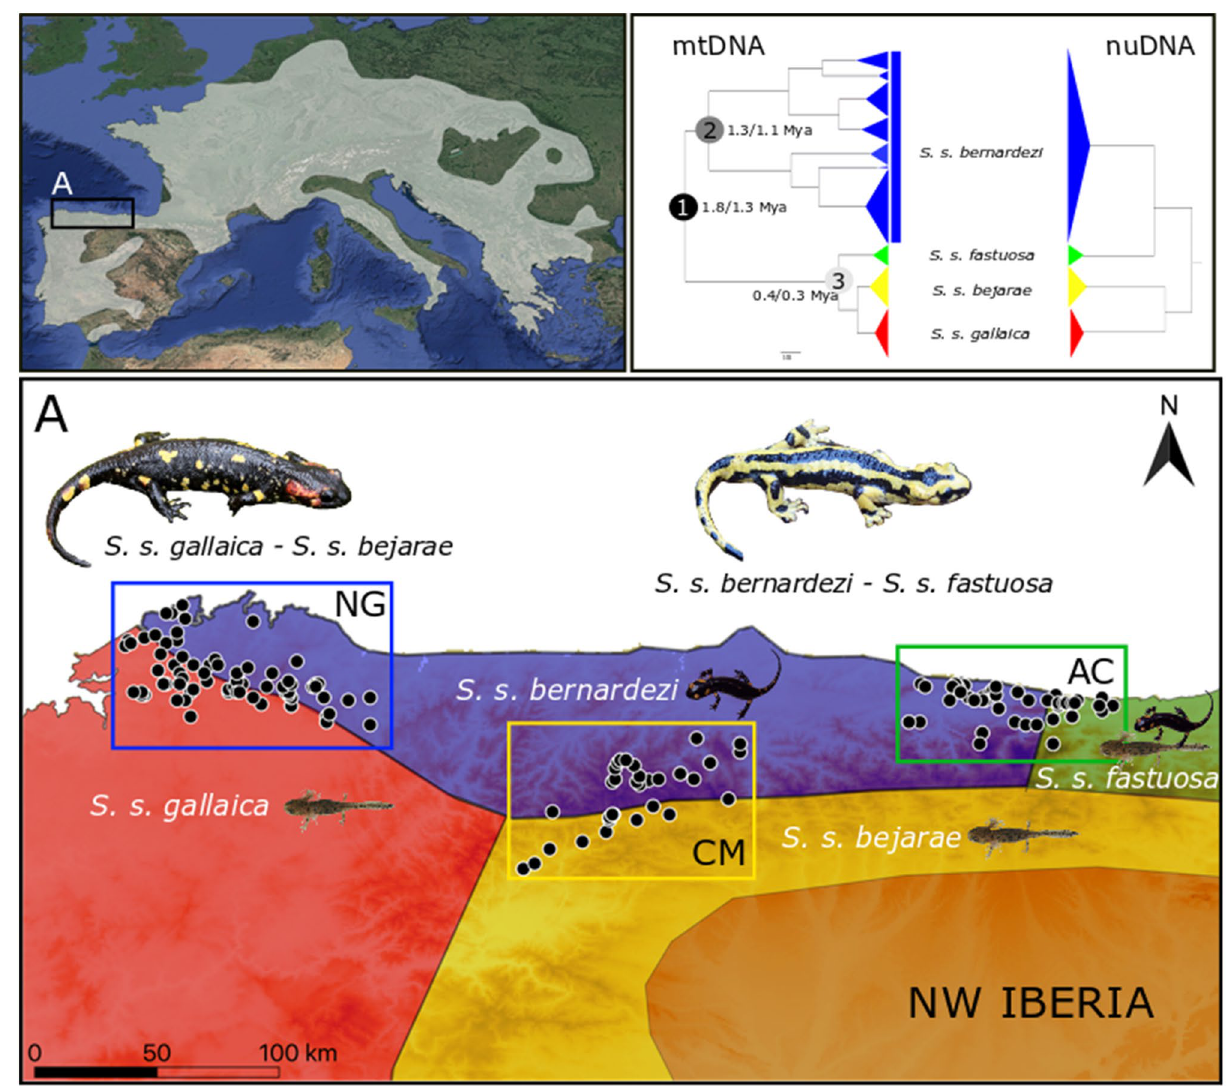
Figure 1. Upper left: distribution of the fire salamander, Salamandra salamandra , with the study area denoted with an inset ( A ). Upper right: mtDNA and nuDNA trees to show subspecies relationships and approximate dates of major splits. The mtDNA tree was generated with cytochrome b sequences from this study while the nuDNA tree is adapted from the topology obtained with phylogenomic data in Burgon et al. 30 . Bottom: sampling sites across each of the studied contact zone: North Galicia (NG), Cantabrian Mountains (CM) and Asturias- Cantabria border (AC). Adult salamander images represent the two morphotypes, while the reproductive mode of each studied subspecies (larviparous, pueriparous or both) is represented on the polygons depicting each subspecies’ distribution. The figure was created with QGIS software (version 3.2; https:// qgis. org/ en/ site/). The satellite image was retrieved from Google Earth using the QuickMapServices